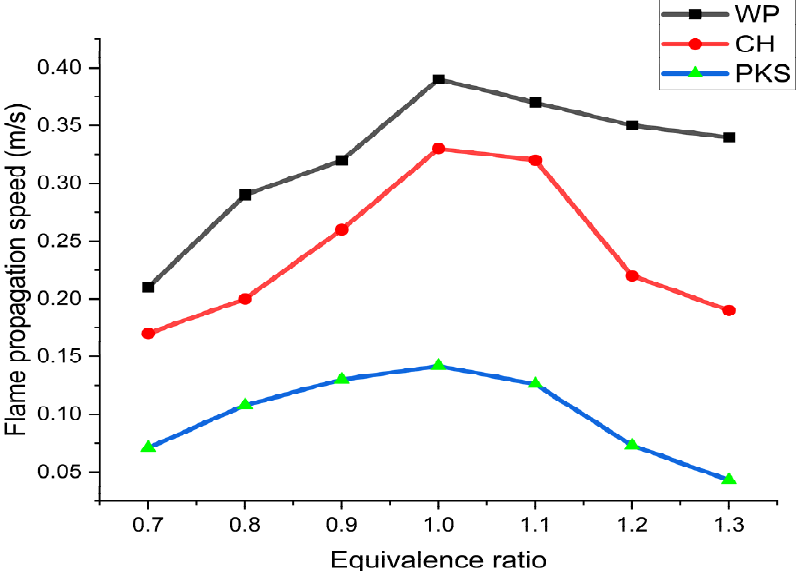
Figure 8. Flame propagation speed of 3 BPGs at 𝜙 from 0.7 to 1.3.